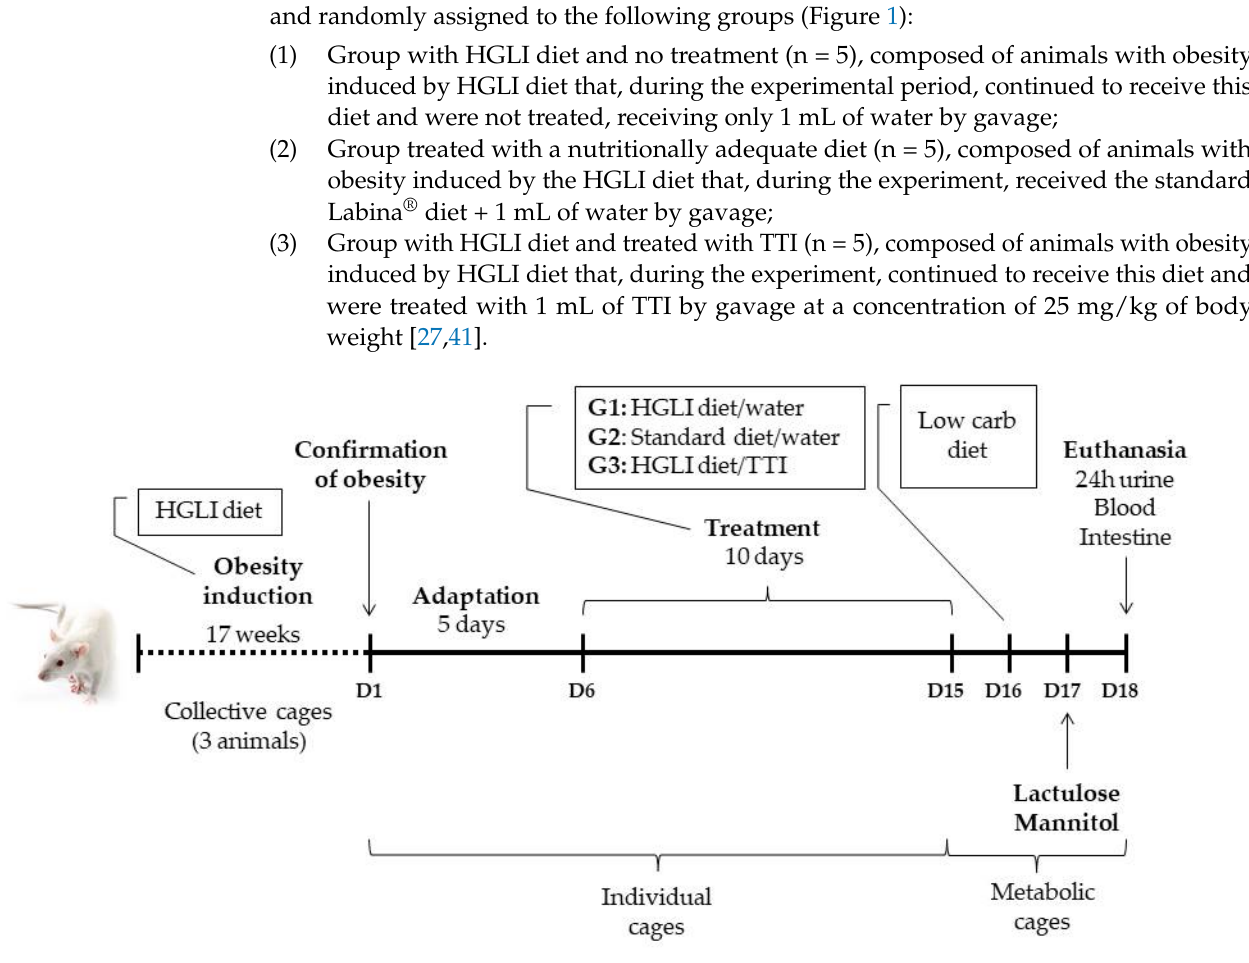
Figure 1. Timeline with the main events of the experimental design of the study with adult male Wistar rats (n = 15). The beginning of the timeline occurred shortly after weaning (21 days after birth). Obesity was previously induced with a high glycemic index and high glycemic load (HGLI) diet. Then, the animals were divided into three groups (n = 5) and subjected to adaptation in individual cages. Thirteen days of experiment followed: ten of treatment and three for the intestinal permeability test. On the 13th day of the experiment, the animals were euthanized for blood and small intestine collection.